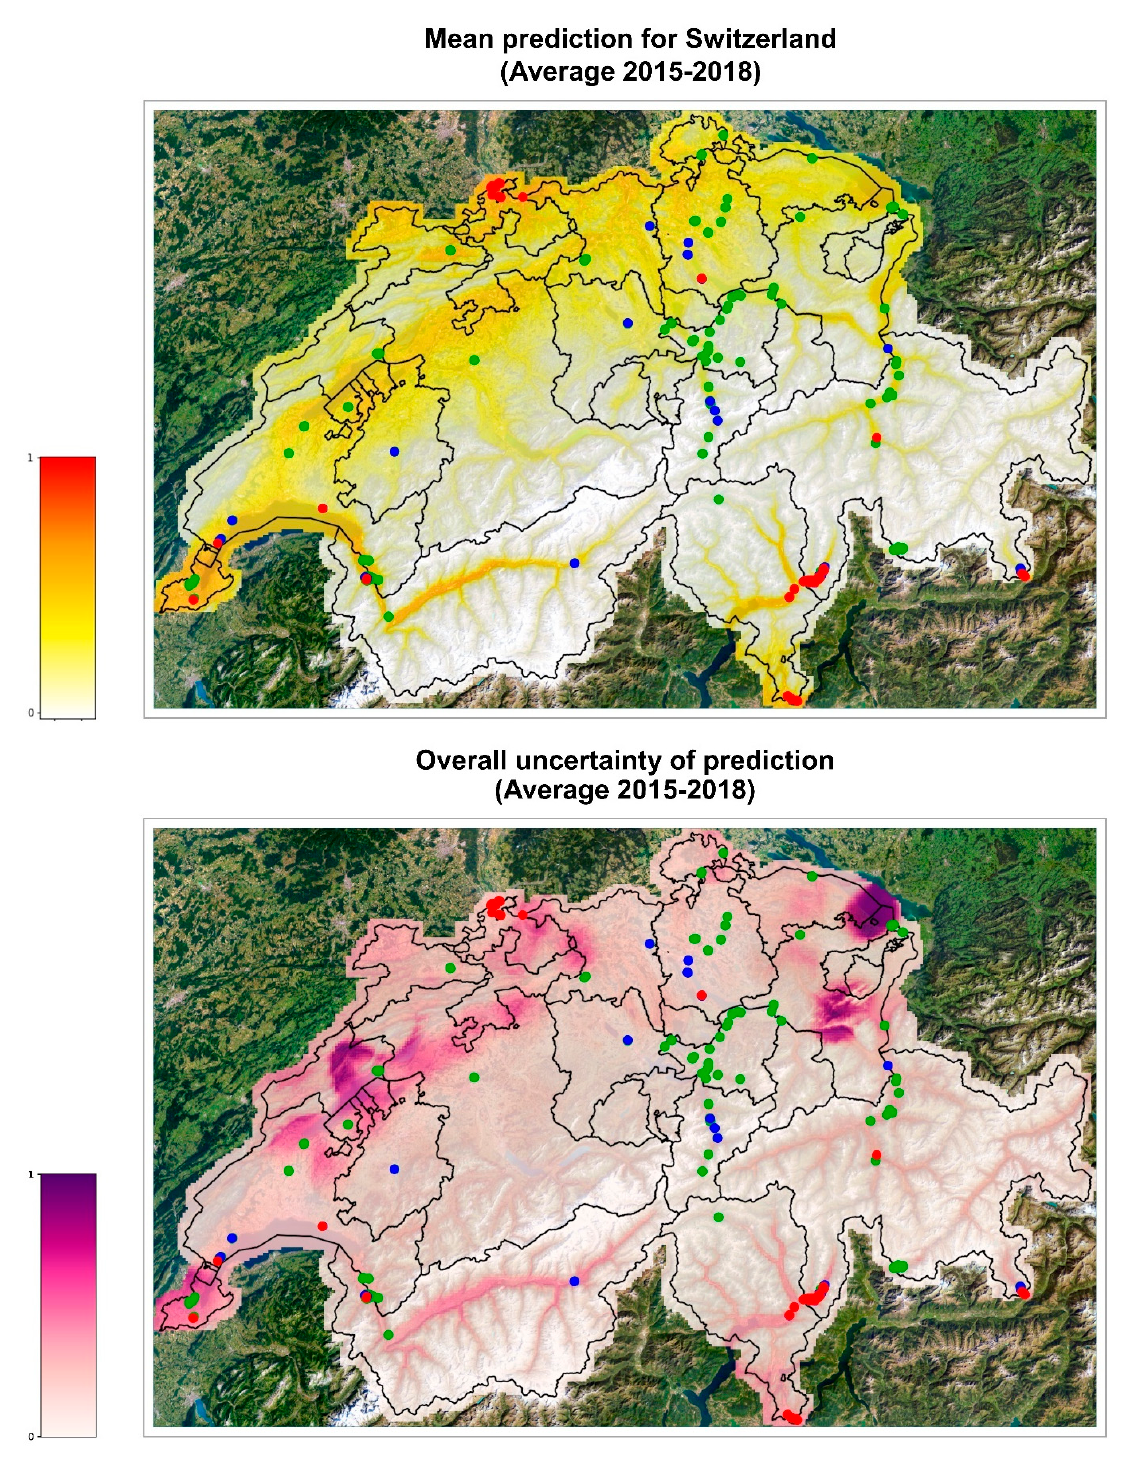
Figure 3. Probabilities of establishment of Ae. albopictus in Switzerland. The map on top shows the average risk estimate over the years 2015–2018. The color gradient shows the probability of establishment from 0 (white) to 1 (red). The bottom map represents the uncertainty of the prediction (higher values representing more uncertain predictions). Dots show cells where the presence of Ae. albopictus was monitored in 2021, the color green representing cases where it was found absent from the cell, blue where it was present but not established, and red where it was established (data source: Swiss Mosquito Network and info fauna—CSCF). Maps modified from https://map.geoadmin.ch/ (accessed on 24 February 2022).